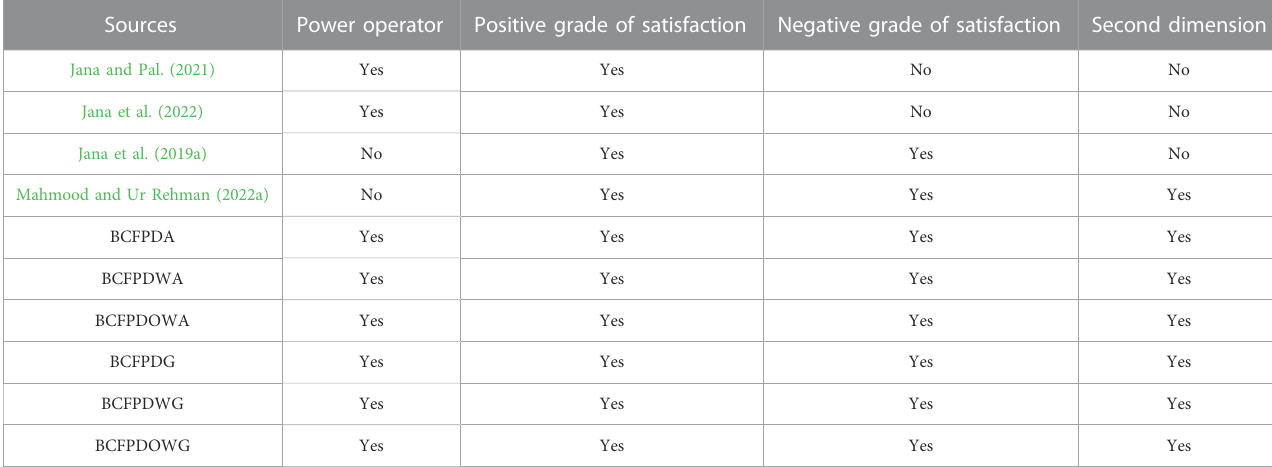
TABLE 2 Comparison of the derived operators with certain existing operators.